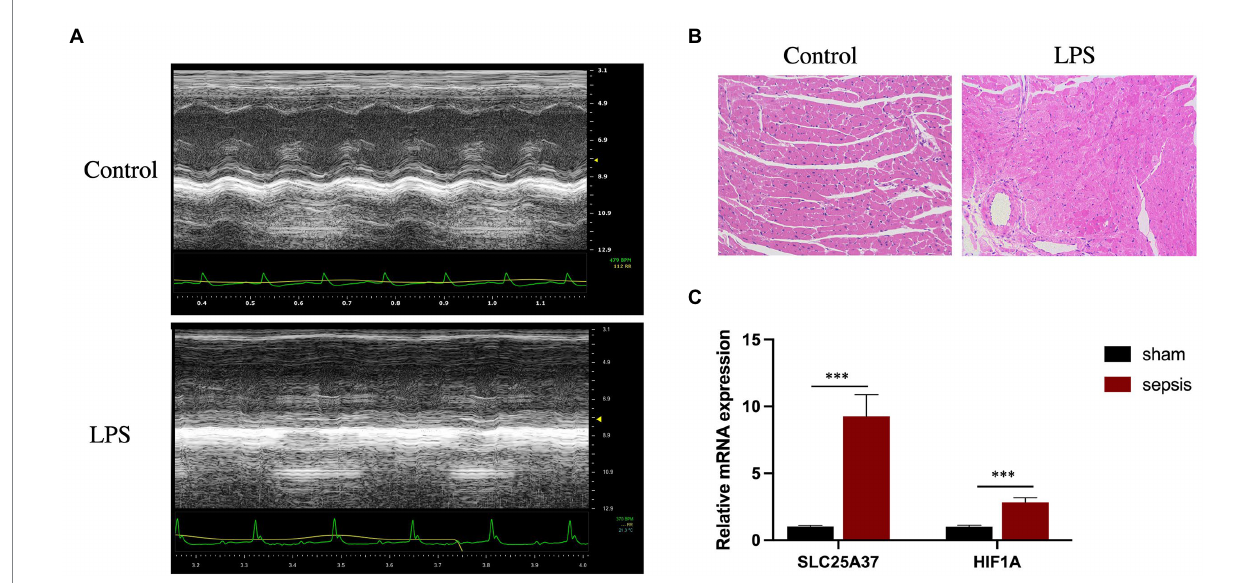
FIGURE 6 Validation of SLC25A37 and HIF1A in a mouse model of LPS-induced sepsis using quantitative PCR analysis. (A) Transthoracic echocardiography between sepsis and control groups. (B) Hematoxylin and eosin staining. (C) Relative expression of SLC25A37 and HIF1A between sepsis and control groups in mice, along with the expression of β -actin as an internal standard for normalization. Asterisks indicate a significant statistical p -value calculated using Student’s t -test (* p < 0.05; ** p < 0.01; *** p < 0.001).